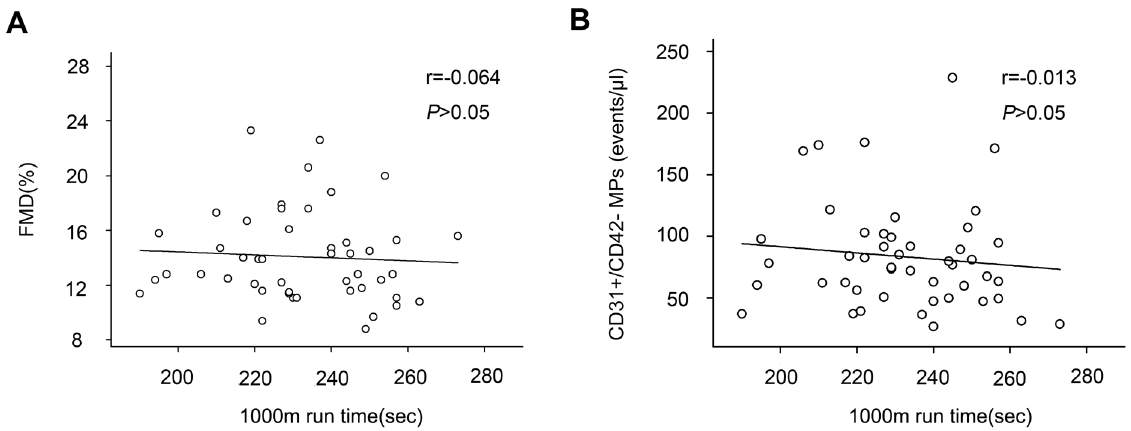
Figure 3. No correlations between 1000 m run time and indicators of endothelial function. 1000 m run time was neither correlated with FMD (A) nor levels of circulating CD31 + /CD42- microparticles (B) in the whole subjects.